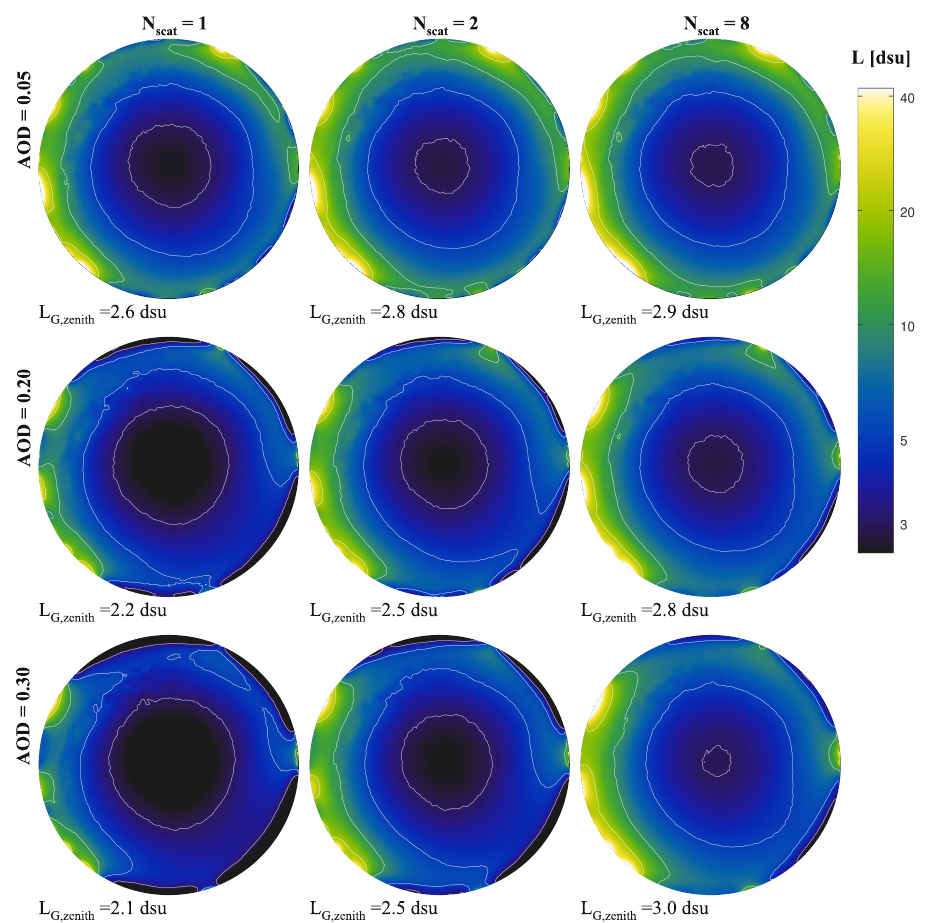
Figure 7. Dependence of calculated sky radiance on the number of